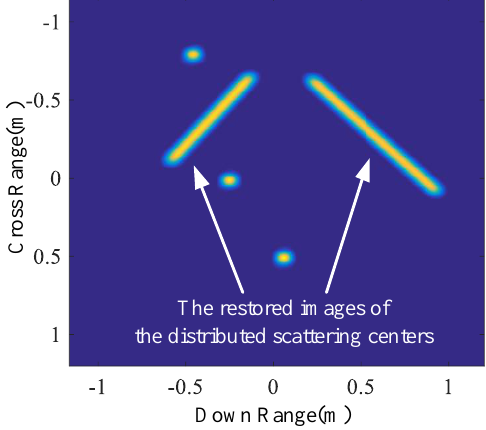
Figure 14. The imaging result with the enhanced features.